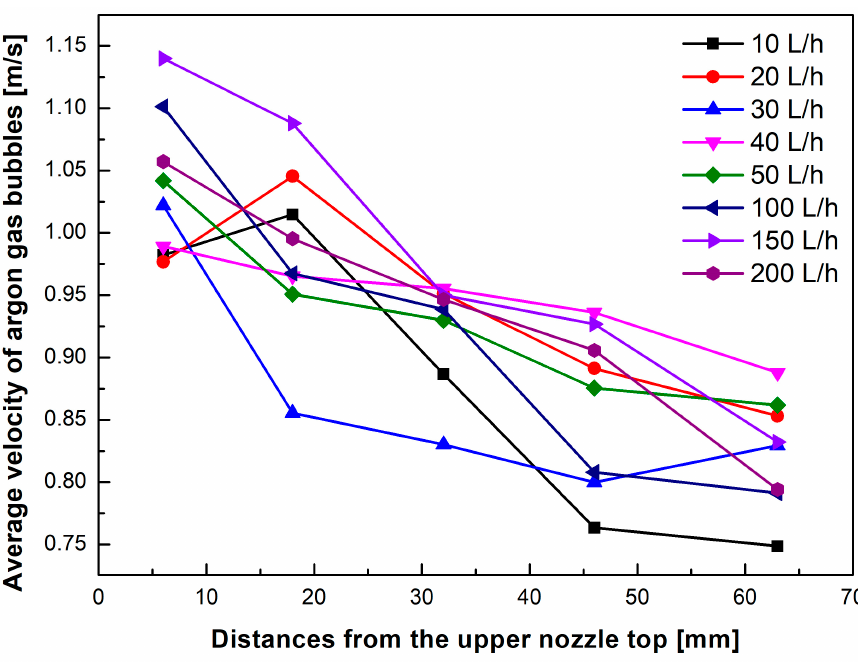
Figure 11. Average velocities of argon bubbles at different heights for different argon flow rates.